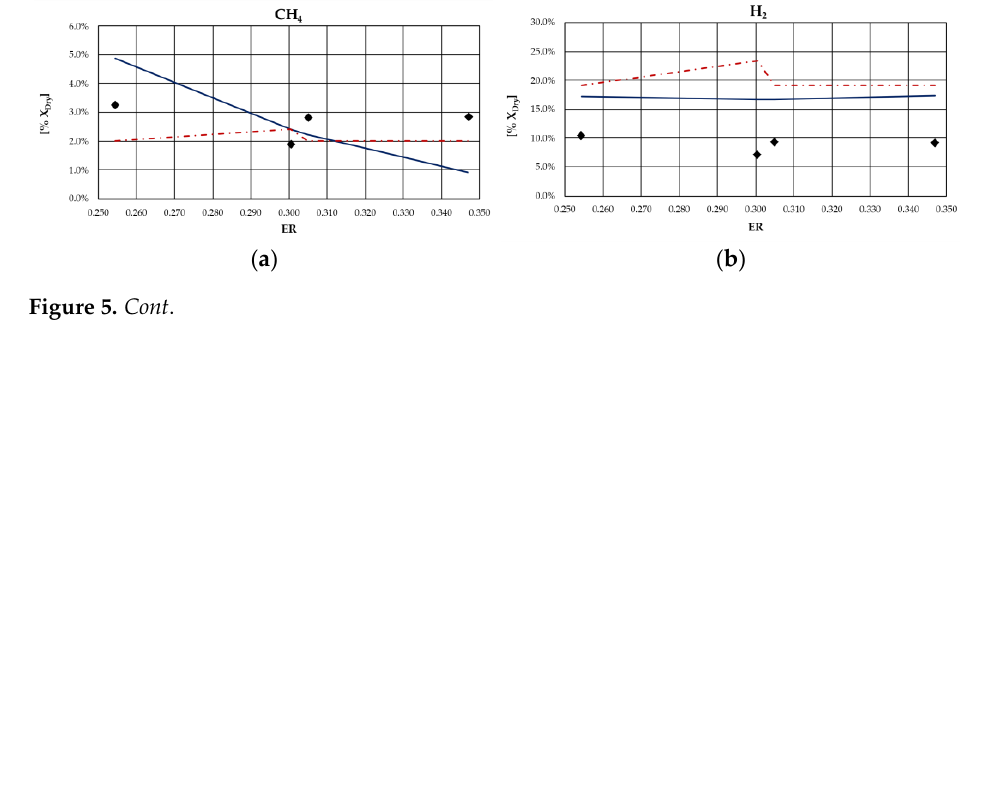
Figure 4. Comparison of syngas mole fraction composition between the results of calibrated and non-calibrated analytical and Aspen models and experimental data from rubber wood gasification [67]: ( a ) CH 4 mole fraction; ( b ) H 2 mole fraction; ( c ) CO mole fraction; ( d ) CO 2 mole fraction; ( e ) N 2 mole fraction.